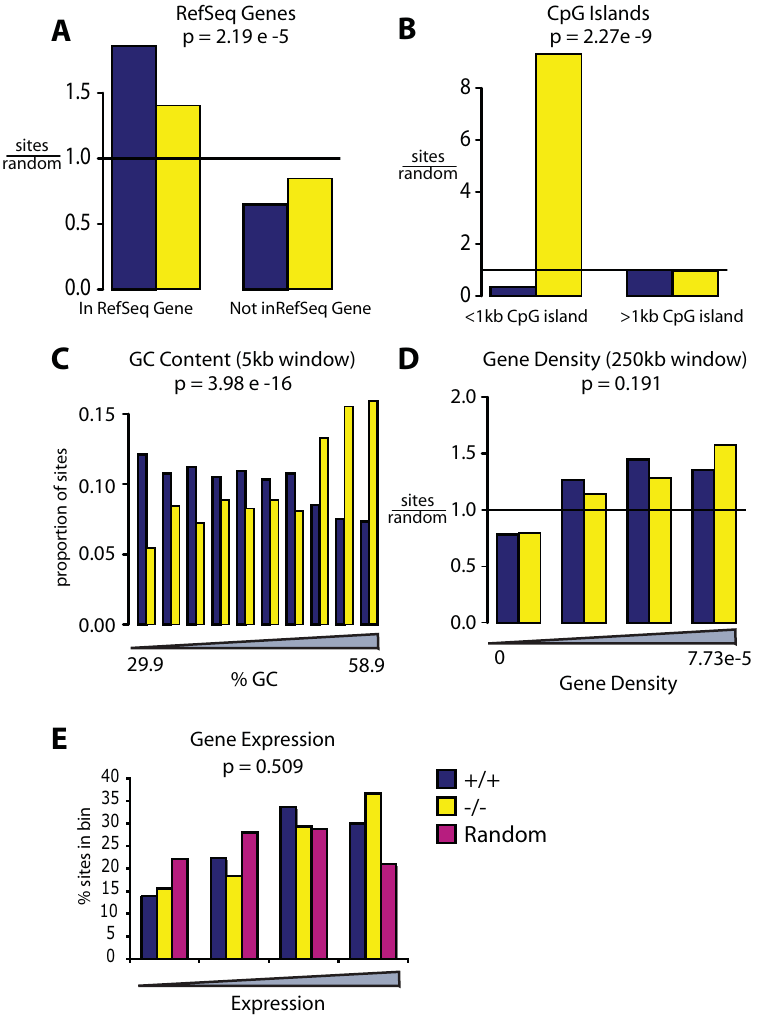
Figure 8. HIV integration distributions in murine control and LEDGF/p75-disrupted cells. A) RefSeq genes, B) CpG islands (1 kb window), C) G/C content, D) Gene density (250 kb window), E) Gene activity. Markings as in Figure 4.